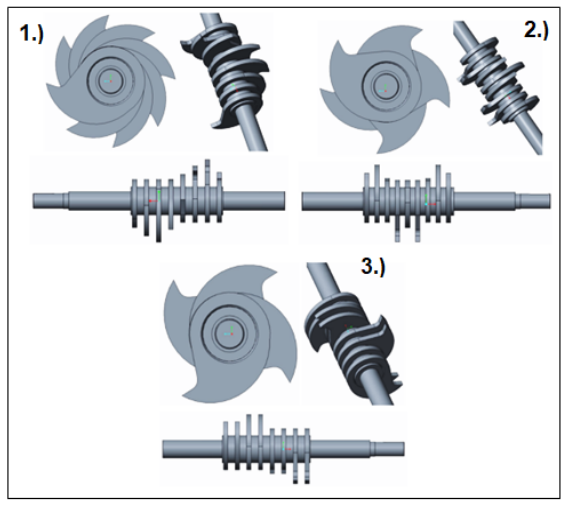
Figure 2 Design solution of a crusher for waste